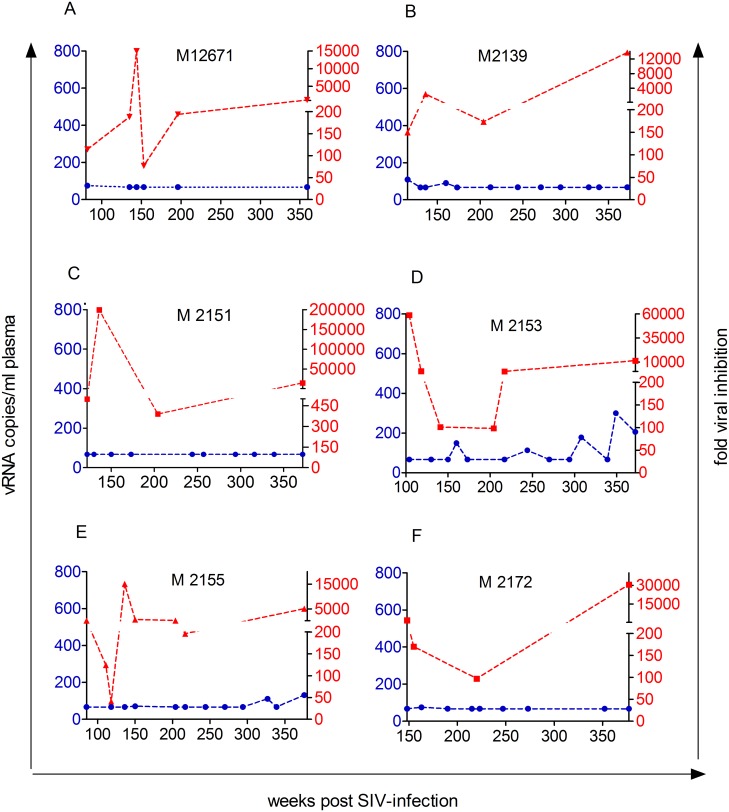
Longitudinal analysis of in vitro viral inhibition and plasma viral RNA copies in SIV-infected LTNPs with undetectable or low plasma viral load.CD8+ cell-mediated inhibition of viral replication (red dashed line) and viral RNA copies per ml plasma (blue dashed line) was measured over a period of up to 6 years. Data are shown from the first time point when viral inhibition test was performed, the time line depicts weeks post SIV-infection (wpi). One point typically reflects the mean inhibition performed with SIV-infected CD4+ cells from two different donors. Respective monkey IDs are shown in each graph.